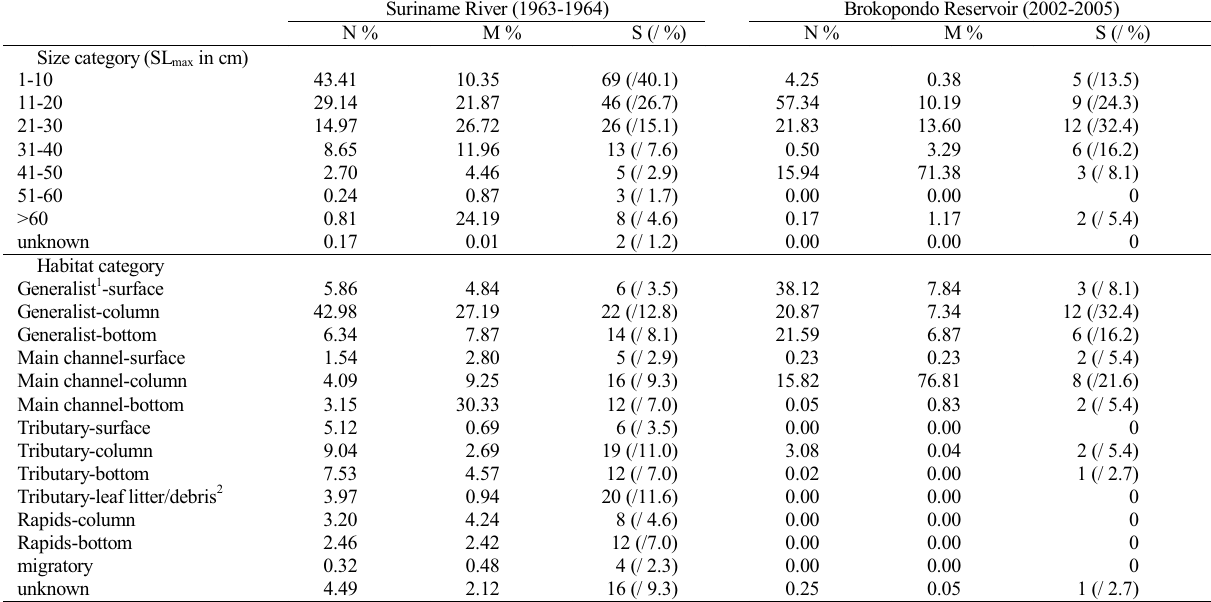
Table 3 . Size (maximum Standard Length; cm) distribution of fish faunas of Suriname River Basin (1963-1964) and Brokopondo Reservoir (2002-2005), and habitat distribution of fishes of Suriname River Basin and representation of fishes from riverine habitats in Brokopondo Reservoir; proportions in number of specimens N, wet mass M, number of species (/ %) and richness (S). The habitat generalist category contains species well represented in more than one habitat (main channel, tributary, rapid) 1 . The tributary-leaf litter/debris category contains species from leaf litter and woody debris habitats 2